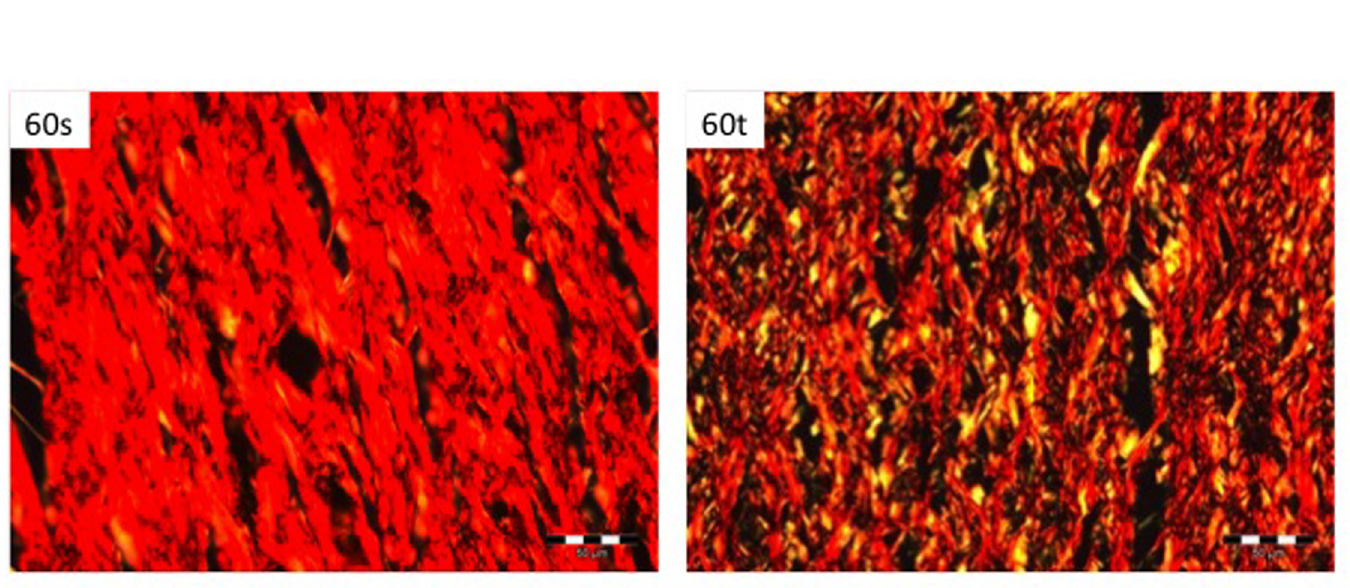
Fig 8. Example pictures of picrosirius red staining under polarized light of both study groups on day 60.